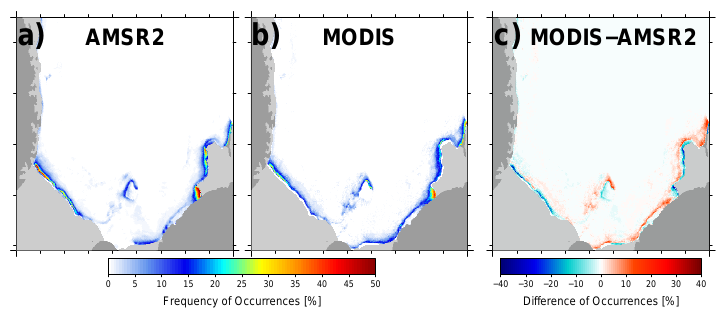
Figure 4. Comparison between frequency of low sea-ice concentration occurrences ( < 70%, AMSR2) and frequency of thin-ice occurrences ( < 0.2m, MODIS) for the years 2013 and